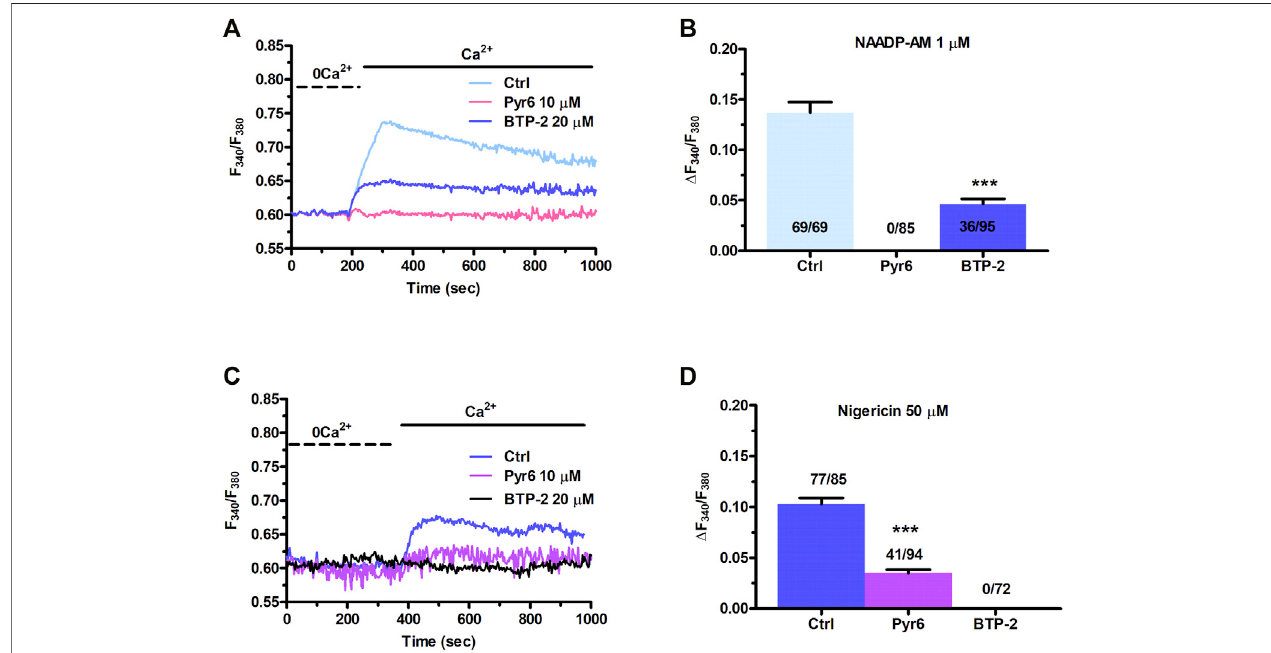
FIGURE 5 | NAADP-AM-induced lysosomal Ca 2+ mobilization is functionally coupled to SOCE in C-MSCs. (A) The in fl ux of extracellular Ca 2+ evoked by NAADP- AM (1 µM) upon depletion of intracellular Ca 2+ stores (Ctrl) was severely affected by inhibiting SOCE with Pyr6 (10 μ M, 10 min) or BTP-2 (20 μ m, 20 min). The previous NAADP-AM-evoked endogenous Ca 2+ release has not been shown. (B) Mean ± SE of the amplitude of NAADP-AM-evoked Ca 2+ entry evoked by nigericin in the absence (Ctrl) and presence of Pyr-6 and BTP-2. Student ’ s t-test: *** p < 0.001. (C) Nigericin-evoked extracellular Ca 2+ entry was attenuated or inhibited by, respectively, blocking SOCE with BTP-2 (20 μ M, 20 min) or Pyr6 (10 μ M, 10 min). (D) Mean ±SE ofthe amplitude of Ca 2+ entryevoked by nigericin inthe absence (Ctrl) and presence of Pyr-6 and BTP-2. Student ’ s t-test: *** p < 0.001.